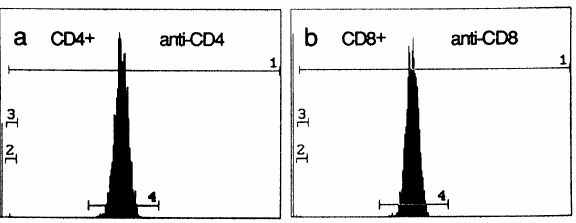
FIG. 1. Purity of T-cell subsets. T-cells were isolated from peripheral blood and subpopulations thereof were purified by positive selection using immunomagnetic beads coated with anti-CD4 or anti-CD8 mAb. FACS analysis confirms purity of 96% for CD4+CD8 (a) and 99% for CD8+CD4 (b). These results are from a representative experiment.